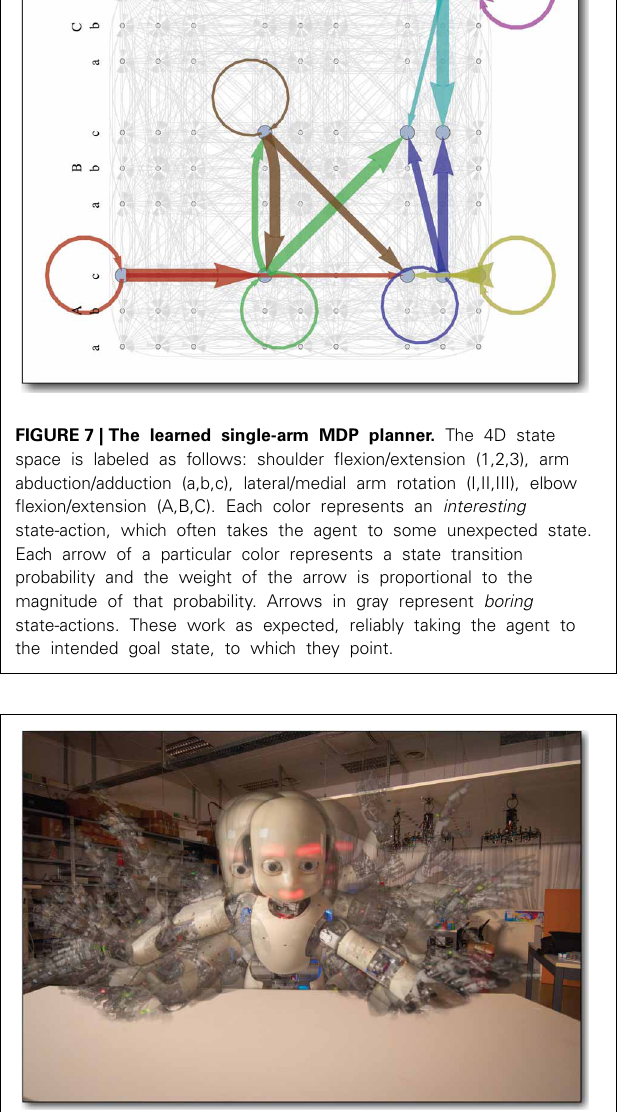
FIGURE 8 | Autonomous exploration. This composite consists of images taken every 30s or so over the first hour of the experiment described in section 3.2.1. Although learning has just begun, we already begin to see that the cloud of robot poses is densest (most opaque) near the table. Note that the compositing technique as well as the wide angle lens used here create the illusion that the hands and arms are farther from the table than they really are. In fact, the low arm poses put the hand or the elbow within 2cm of the table, as shown in Figure 8 .